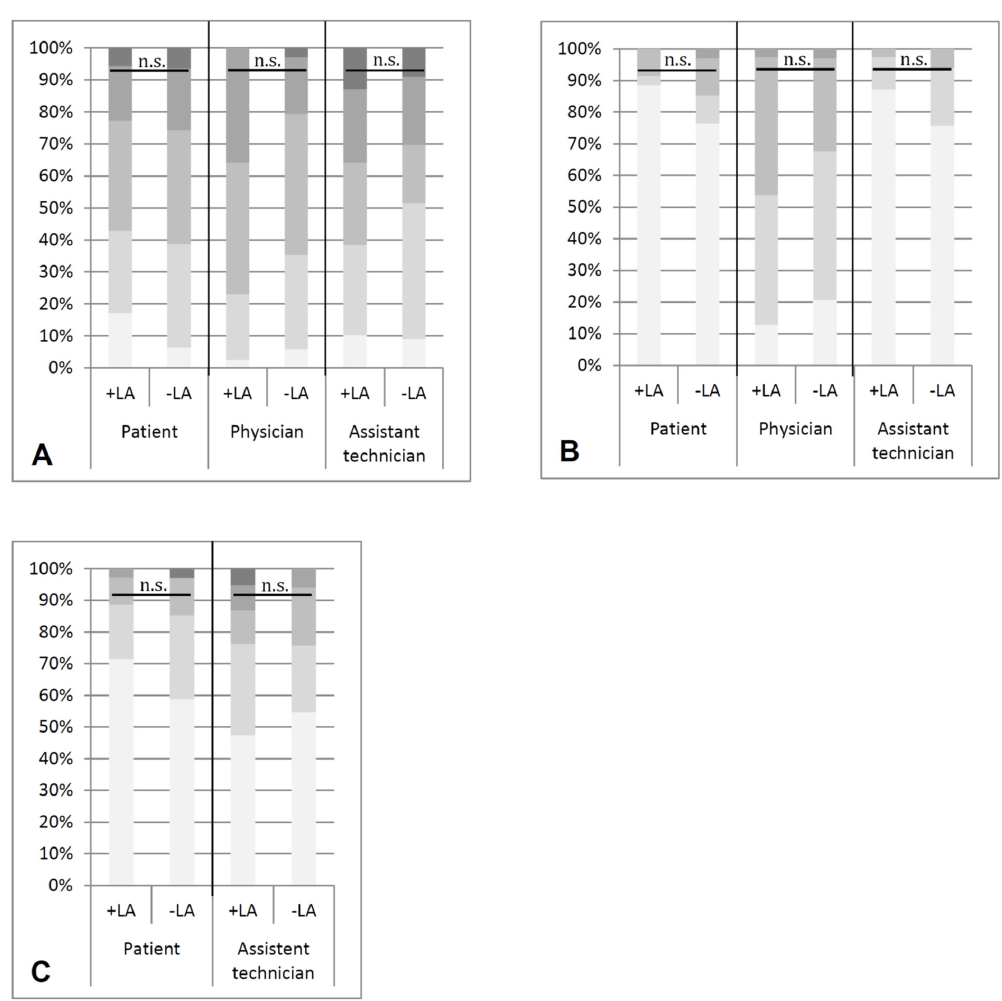
Figure A3. Box plots show median and quantiles for absolute number of single coughs ( A ), cough clusters ( B ) and the sum of both ( C ) for each patient during the 10-min evaluation interval, separately for both standards (S1 (+LAP)—Standard 1 with local anaesthesia of the pharynx; S2 ( − LAP)—Standard 2 without local anaesthesia of the pharynx).